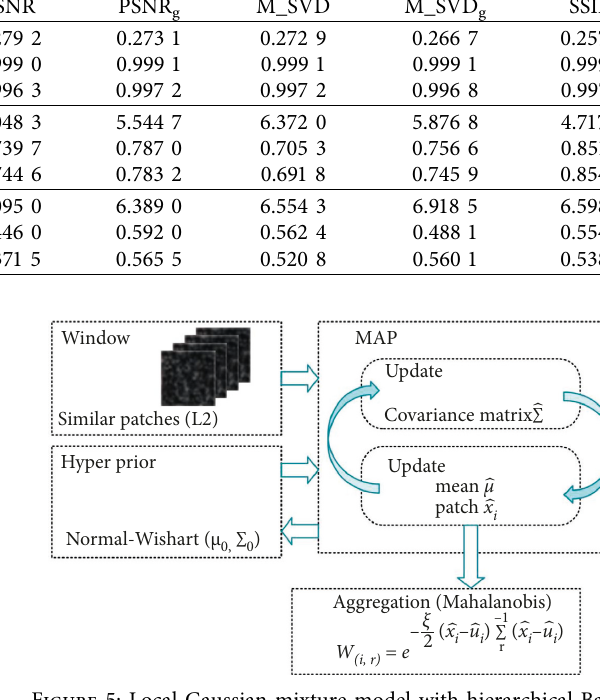
Figure 5: Local Gaussian mixture model with hierarchical Bayes model.